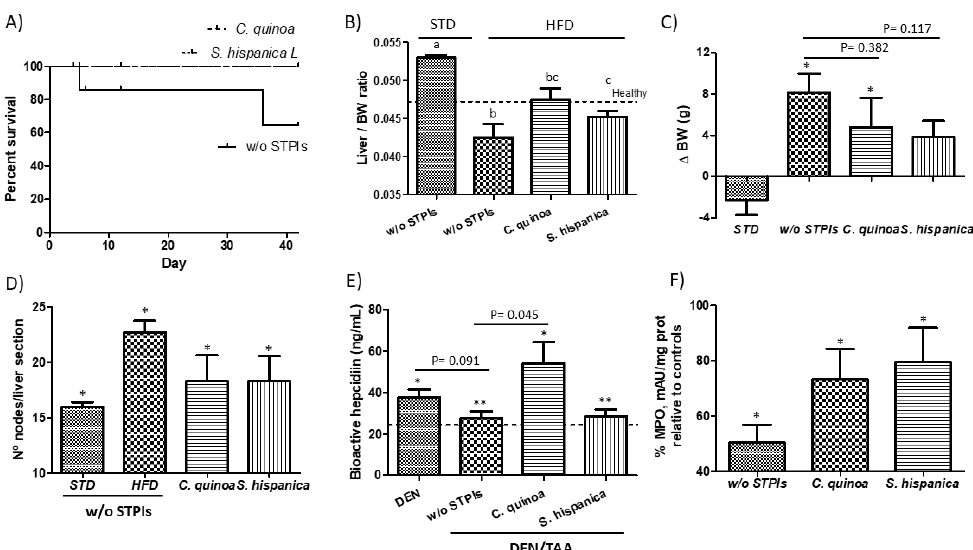
Figure 1. Hepatocarcinoma (HCC) development by the concurrent diethylnitrosamine (DEN) injection and thioacetamide (TAA) administration to 6 weeks old C57BL / 6 mice. ( A ) Impact of protease inhibitors (PIs) in percent survival of HCC developing mice. ( B ) Changes in liver to body weight (BW) ratio and ( C ) Variations in body weight gain of high fat diet-fed animals receiving PIs. ( D ) Influence of feeding PIs in the intrahepatic accumulation of nodes of mononuclear cells in DEN / TAA-treated mice administered with PIs. ( E ) Serum levels of bioactive hepcidin peptide concentration. ( F ) Hepatic changes in myeloperoxidase activity (MPO) in liver samples of HCC developing mice. * Indicates statistical di ff erences (Tukey–Kramer’s test, p < 0.05) to DEN / TAA-treated animals not receiving